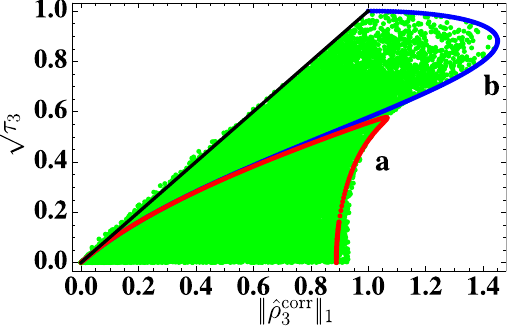
Figure 2. Plot of the three-tangle τ versus the three-point correlation bound ρ 3corr for a random selection 3 1 of 40.000 pure states (4) from the generalized Schmidt decomposition 34, 35 . Each dot in the figure corresponds to 3corr a single state. The thin black line corresponds to τ ρ = ˆ . Most of the states satisfy the inequality 3 1 ρ τ ≥ 3corr (as in the case of two spins where ρ ≥ C 2corr is valid for all pure states) but some of them 1 3 1 2 slightly deviate from it. The lower red (a) and upper blue curve (b) are obtained for GHZ states that are made of two α ( )/ 3